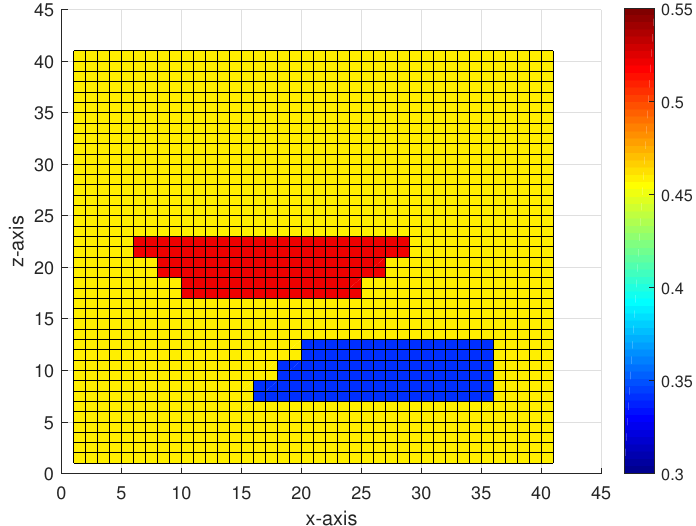
Figure 3. The true